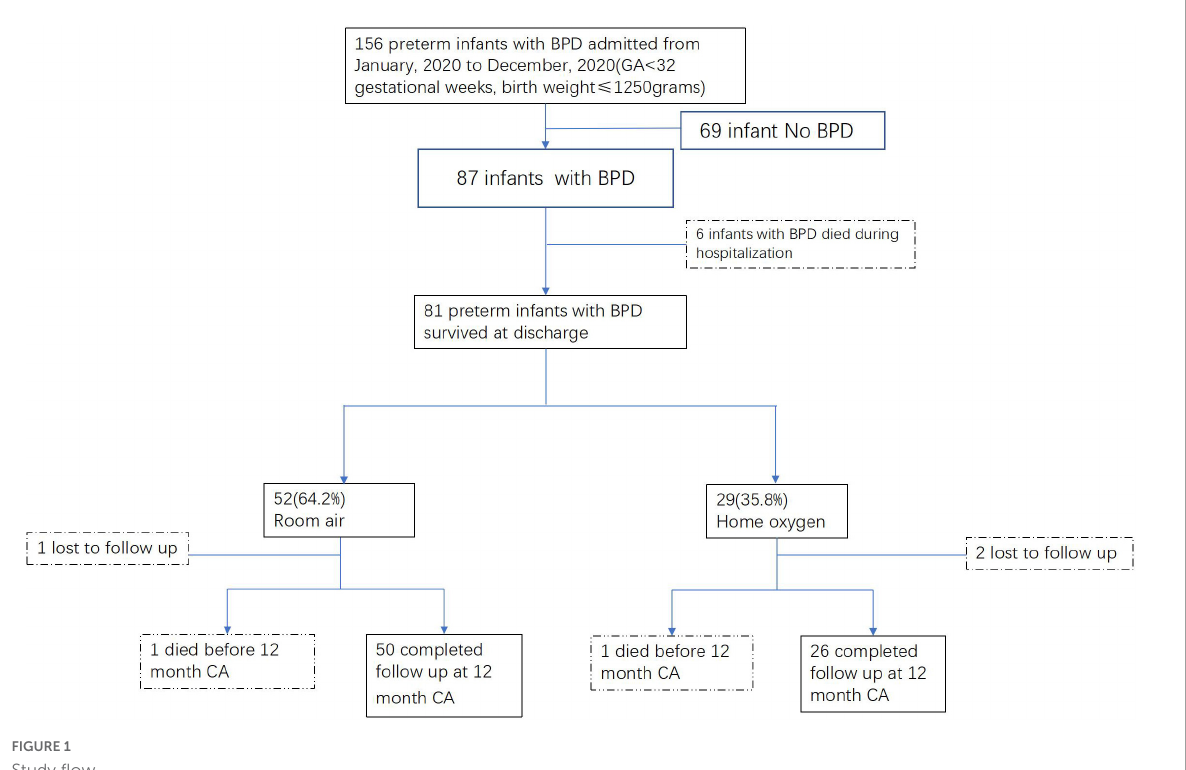
FIGURE1 Study flow.